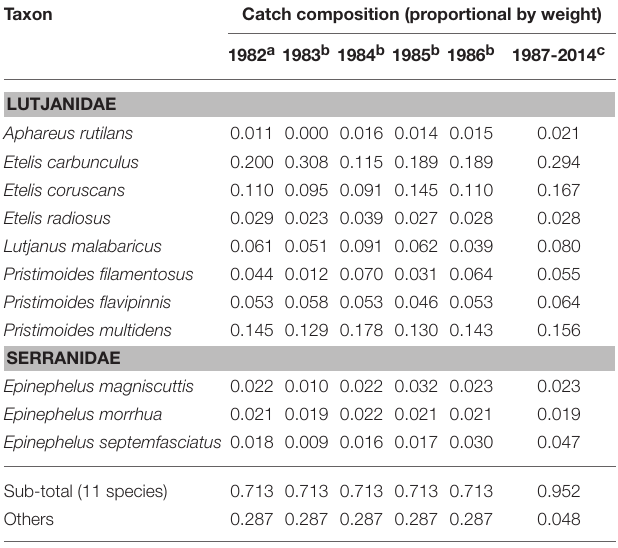
TABLE 2 | Estimated taxonomic breakdown of the finfish catches of the deep-bottom fisheries in Vanuatu, 1950–2014. Taxon Catch composition (proportional by